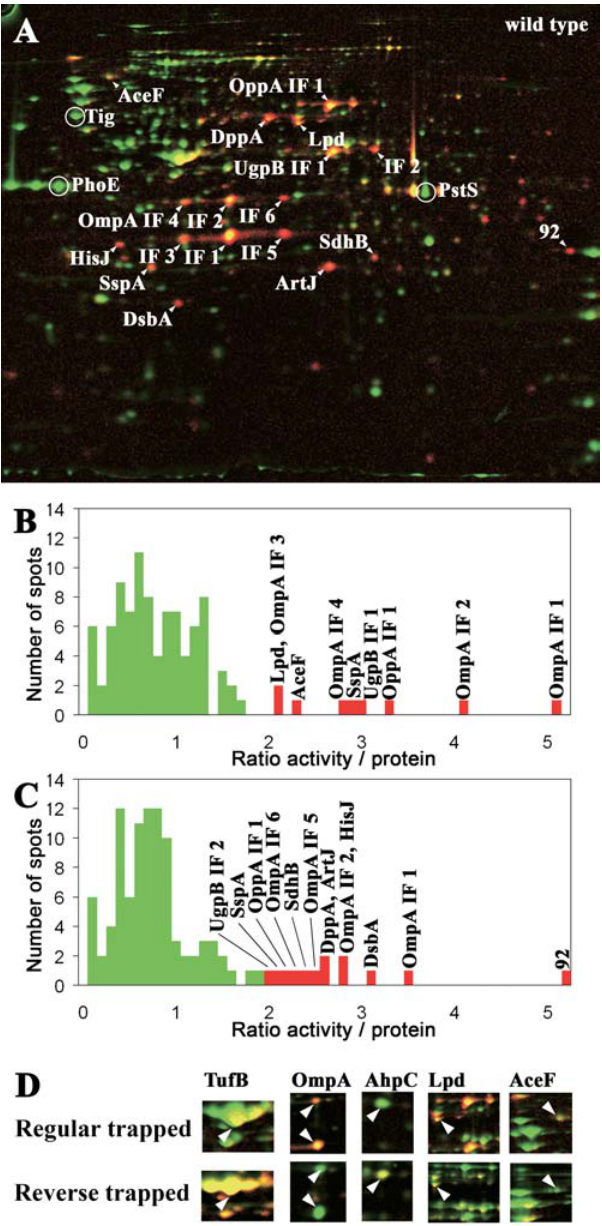
Figure 2. Overall Thiol-Disulfide State of Cellular Proteins in Exponen- tially Growing E. coli Wild-Type Cells (A) Colored overlay of the Coomassie blue–stained 2D gel (shown in green) and the phosphor image (shown in red) of a differentially trapped protein extract from exponentially growing E. coli wild-type cells. Proteins with a high ratio of 14 C activity/protein appear red; proteins with a low ratio appear green. Protein spots with a ratio of 14 C activity/protein greater than 2.0 are indicated by an arrow, while circles label abundant proteins without cysteines. (B) Distribution of the 14 C activity/protein ratio in the 100 most abundant protein spots found on a Coomassie blue–stained gel. Bars representing spots with a ratio higher than 2.0 are colored red and are labeled with the name of the protein(s) they represent. (C) Distribution of the 14 C activity/protein ratio in the 100 most intense protein spots found on the phosphor images. Bars represent- ing spots with a ratio higher than 2.0 are colored red and are labeled with the name of the protein(s) they represent. (D) Regular and reverse trapping of exponentially growing E. coli wild-type cells. Details of colored overlays of stained protein gels (shown in green) and phosphor images (shown in red) of cell extracts upon regular trapping (top) and reverse trapping (bottom). DOI: